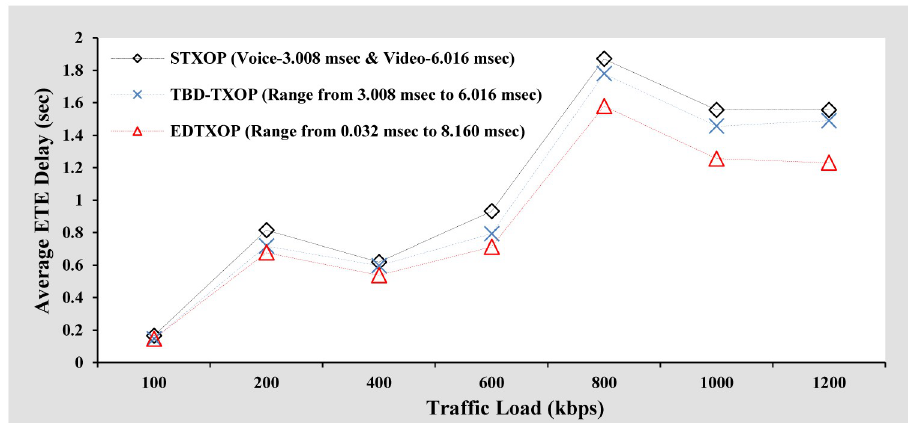
Fig 6. Average ETE delay analysis based on increasing packet